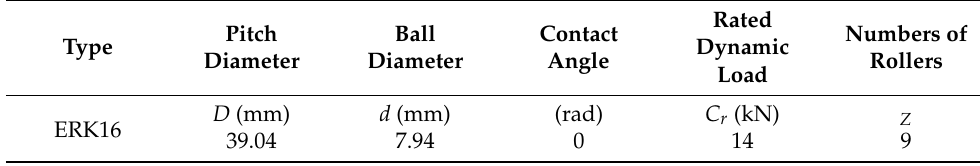
Table 4 . Main geometric parameters of rolling bearing ERK16. Table 4. Main geometric parameters of rolling bearing ERK16.